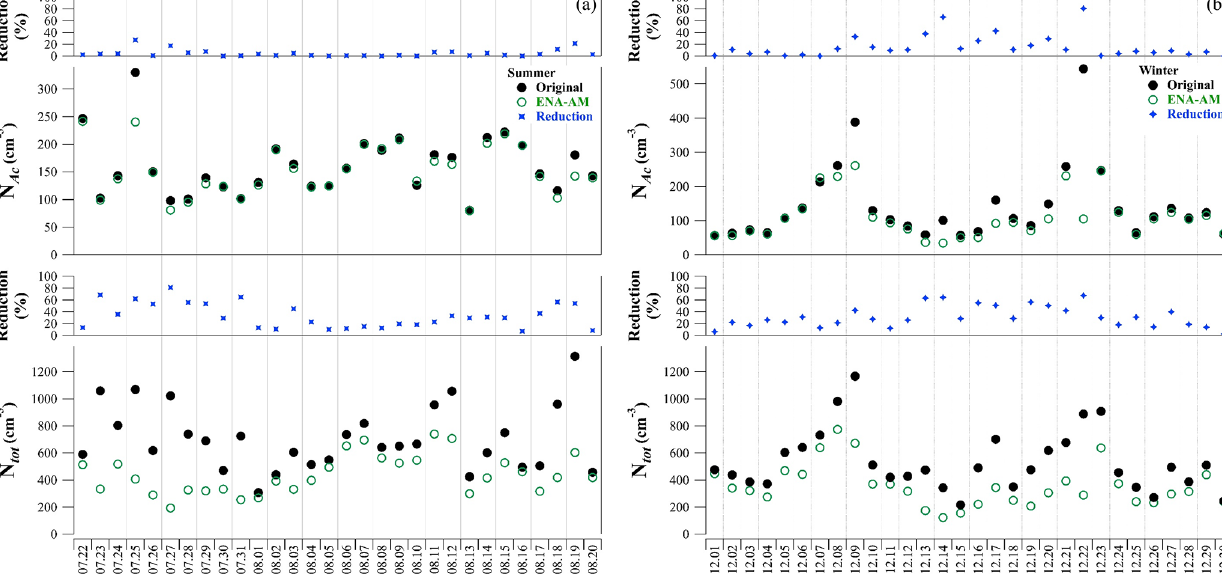
Figure 11. Original (black) and ENA-AM masked (green) N tot and N Ac daily means at C1 and corresponding reduction (%) (blue) in the (a) summer and (b)